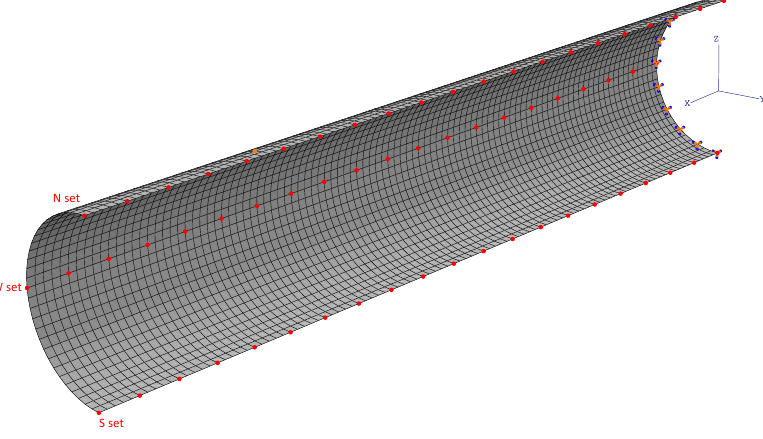
Figure A1. Meshed FE model of the thin-walled cantilever and nodal points to record